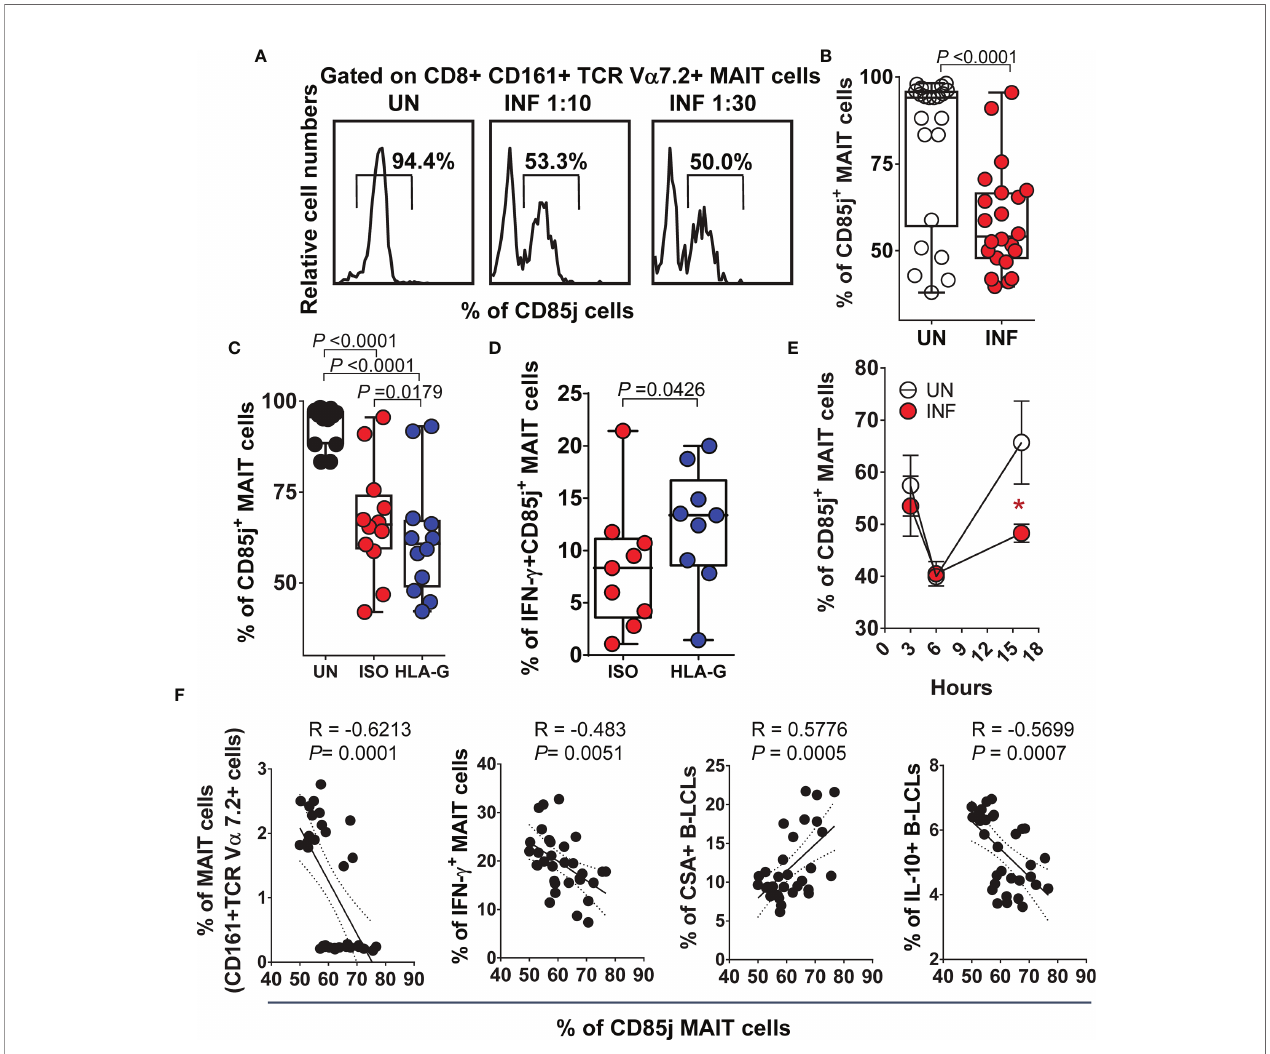
FIGURE 5 | Inhibitory HLA-G receptor CD85j and IFN- g secretion by MAIT cells. PBMC were exposed to either uninfected (UN) or S . Typhi-infected (INF) B-LCL cells treated with Abs to HLA-G (HLA-G) or isotype (ISO) control (2.5 m g/ml). After 16-18 hours of co-culture, cells were collected, and the levels of MAIT cells expressing CD85j and IFN- g were evaluated by fl ow cytometry. To gate on MAIT cells, a “ dump ” channel was used to eliminate dead cells (ViViD + ), as well as macrophages/monocytes (CD14 + ) and B-LCLs (CD45 + ) from the analysis. (A) Representative experiment showing CD85j expression on MAIT cells. (B) Cumulative data. Levels of MAIT cells expressing (C) CD85j only or co-expressing (D) IFN- g after HLA-G blocking. (E) Kinetics of CD85j co-expression on MAIT cells after exposure to UN or INF B-LCLs. Student ’ s t-test was performed to compare CD85j expression on MAIT cells after exposure to UN or INF B-LCLs. *, represent signi fi cant differences ( P <0.05) between MAIT cells exposed to UN ( ○ ) or INF B-LCLs ( (cid:129) ) at the same timepoint. (F) Pearson ’ s correlations among levels of MAIT cells and their expression of CD85j and IFN- g , and the expression of CSA and IL-10 on B-LCLs. Each dot represents a single experimental condition. Data are representative of one out of 2 individual experiments. Bar graphs extend from the 25 th to 75 th percentiles; the line in the middle represents the median of the pooled data. The whiskers delineate the smallest to the largest